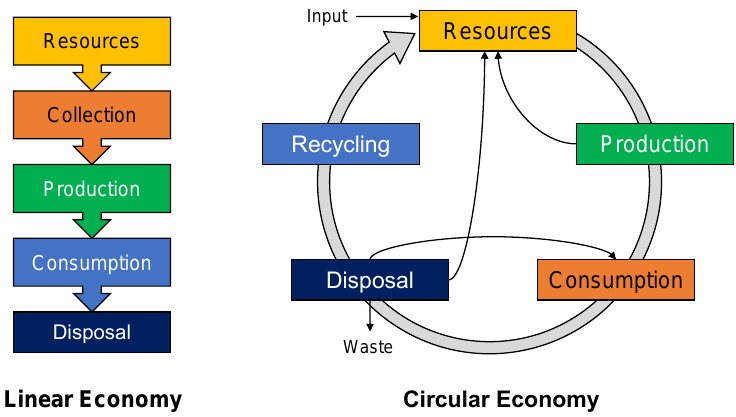
Figure 1. Example linear and circular economy